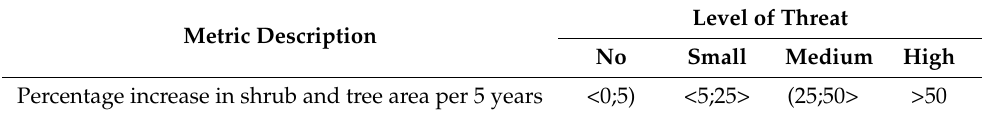
Table 6. The criteria of the threat level in terms of the dynamics of the succession process. Level of Threat Metric Description No Small Medium High Percentage increase in shrub and tree area per 5 years <0;5) <5;25> (25;50>